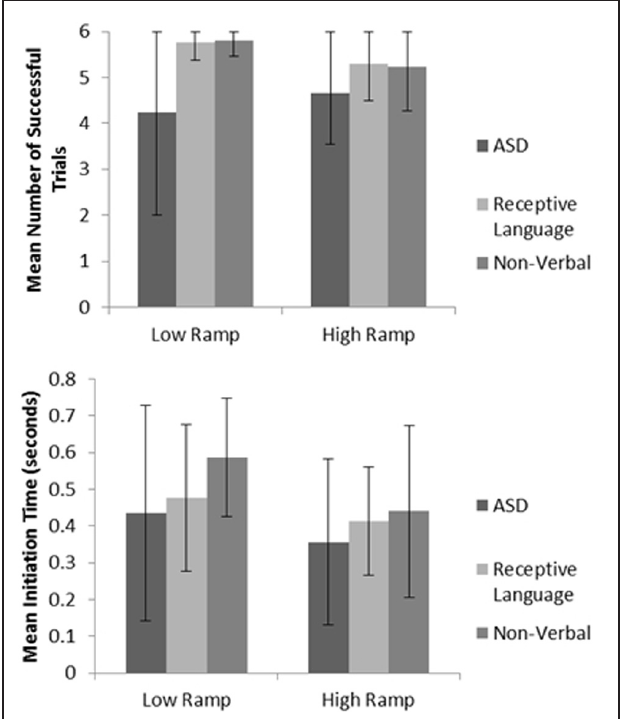
FIGURE 4 | Example summary graphs for spatial accuracy (measured via number of successful catches), and mean initiation time. For full data please see Whyatt and Craig